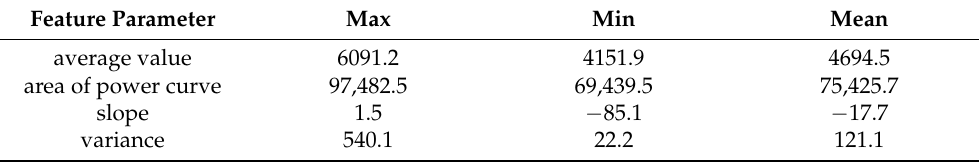
Table 1. The grinding power of fine grinding process and its derived variables.